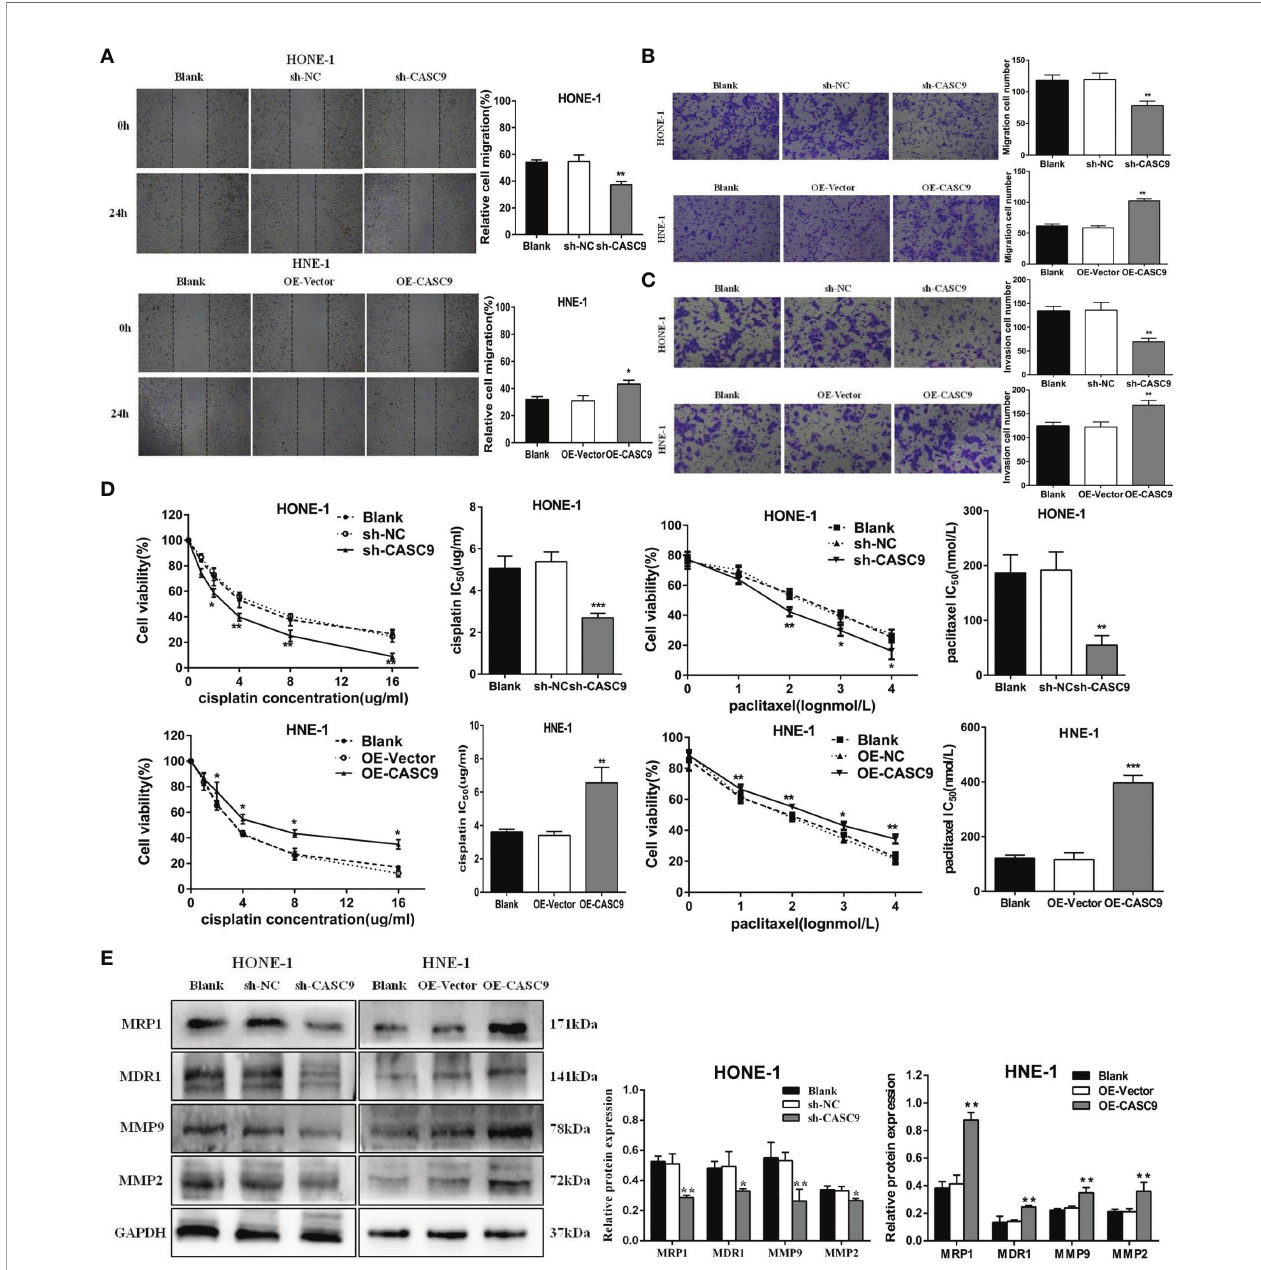
FIGURE 4 | CASC9 facilitated NPC cells migration and invasion and decreased the sensitivity to cisplatin and paclitaxel. (A, B) The migratory abilities of NPC cells were determined using wound healing assay and transwell assay. (C) The invasion abilities of NPC cells were determined using transwell assay. (D) Knockdown of CASC9 expression enhanced the sensitivity of NPC cells to cisplatin and paclitaxel. (E) The expression of related proteins were determined using western blotting. *P < 0.05, **P < 0.01, ***P <